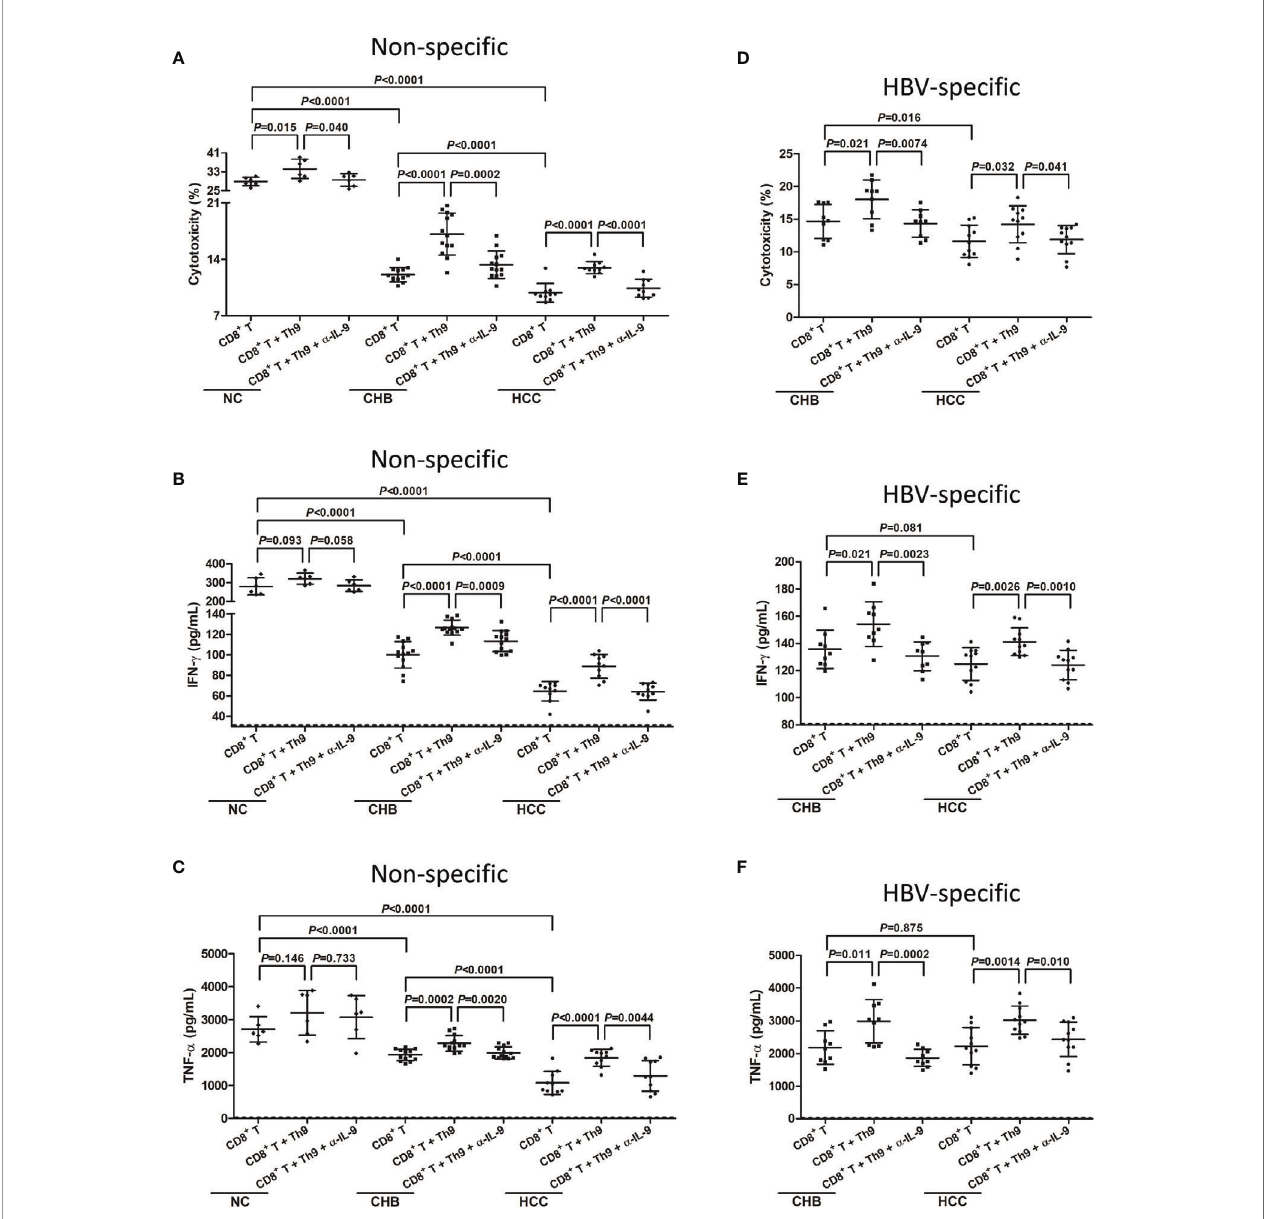
FIGURE 5 | In fl uence of Th9 cells to non-speci fi c and HBV-speci fi c CD8 + T cells in hepatitis B-related hepatocellular carcinoma (HCC). 10 4 of peripheral CD8 + T cells from normal controls (NC, n =6), chronic hepatitis B (CHB) patients ( n =13), and hepatitis B-related HCC patients ( n =10) were co-cultured with HepG2.2.15 cells in a direct contact manner in the presence or absence of 10 4 of autologous Th9 cells or anti-IL-9 neutralization antibody (5 m g/mL). Anti-CD3/CD28 (1 m g/mL) was added for maintenance of non-speci fi c T cell response. Supernatants were harvested 48 hours post co-culture. (A) Percentage of target HepG2.2.15 cell death was measured by LDH release, and was compared among groups in non-speci fi c manners. Signi fi cance was assessed using one-way ANOVA and SNK- q test. (B) IFN- g and (C) TNF- a , which secreted by non-speci fi c CD8 + T cells, was measured by ELISA, and was compared among groups. Signi fi cance was assessed using one- way ANOVA and SNK- q test. 10 4 of peripheral CD8 + T cells from CHB patients ( n =9), and hepatitis B-related HCC patients ( n =11) were co-cultured with HepG2.2.15 cells in a direct contact manner in the presence or absence of 10 4 of autologous Th9 cells or anti-IL-9 neutralization antibody (5 m g/mL). HBV core 18- 27 epitope (sequence: FLPSDFFPSV; 5 m g/mL) was added for maintenance of HBV-speci fi c T cell response. Supernatants were harvested 48 hours post co-culture. (D) Percentage of target HepG2.2.15 cell death was measured by LDH release, and was compared among groups in HBV core-speci fi c manners. Signi fi cance was assessed using one-way ANOVA and SNK- q test. (E) IFN- g and (F) TNF- a , which secreted by HBV core-speci fi c CD8 + T cells, was measured by ELISA, and was compared among groups. The dotted line presented lower detection limit for IFN- g (1.56 pg/mL) and TNF- a (1.95 pg/mL), respectively. Signi fi cance was assessed using one-way ANOVA and SNK- q